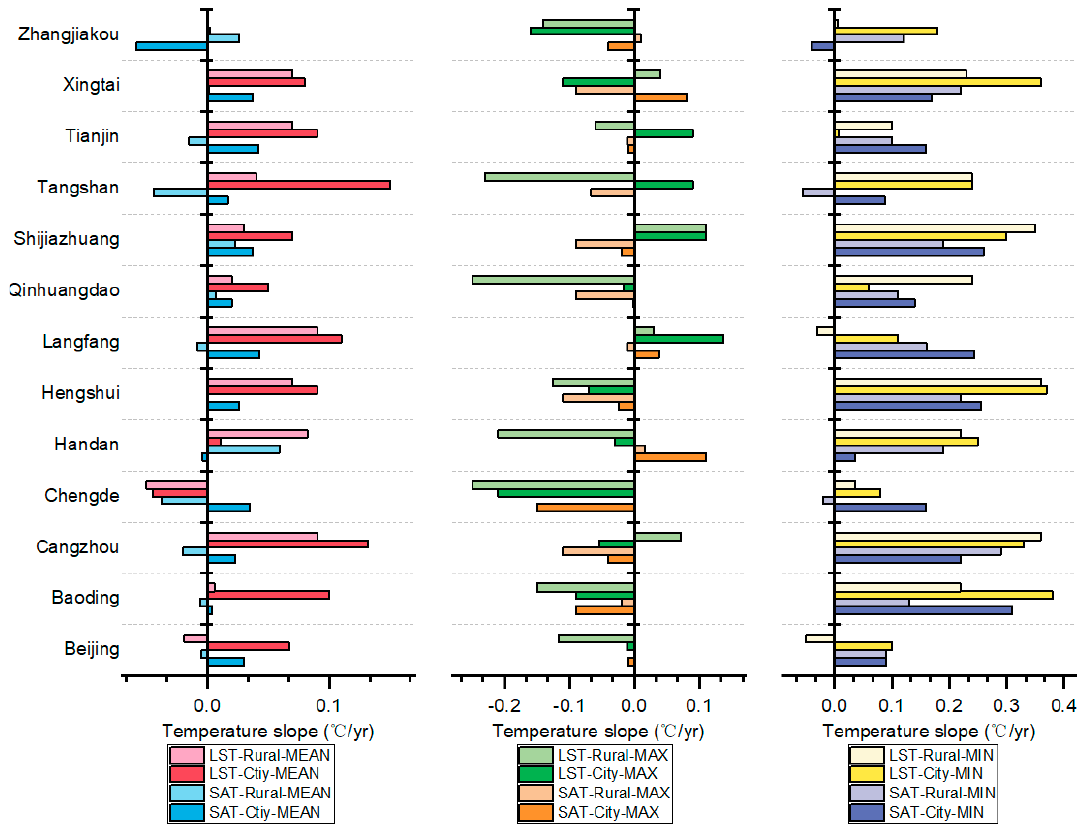
Figure 6. Trend comparisons of LST and SAT temperatures.